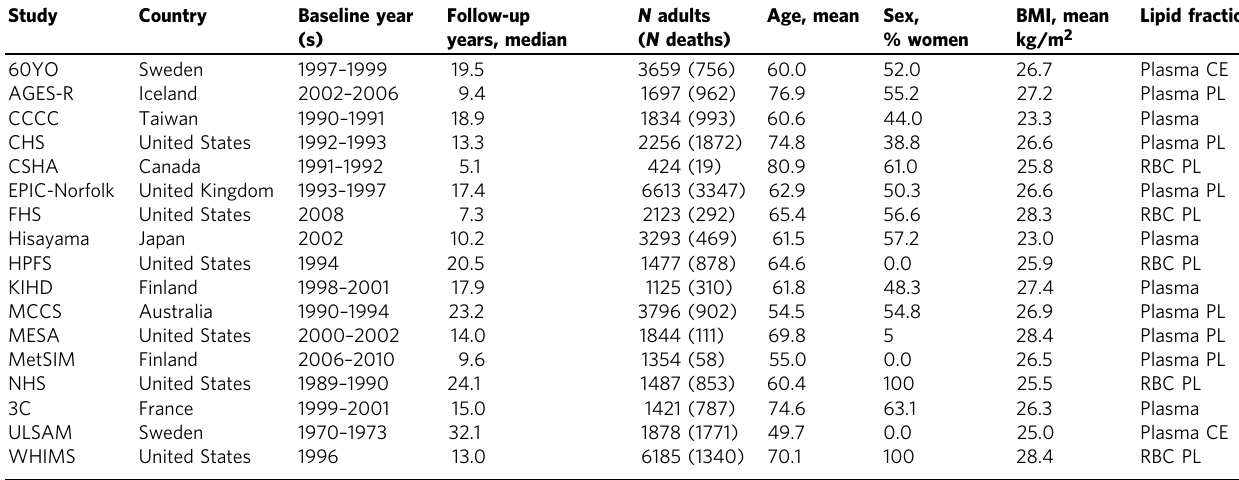
Table 1 Baseline characteristics a of 17 prospective cohort studies included in the meta-analysis: Fatty Acids and Outcomes Research